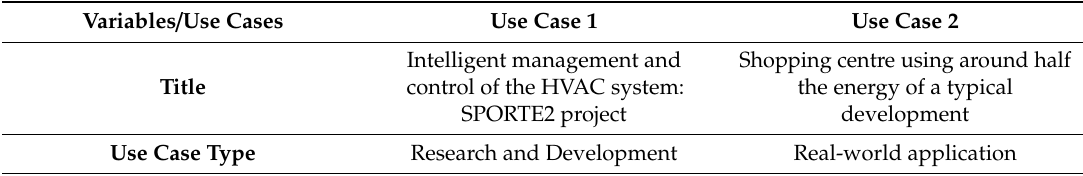
Table 1. Examples of BIM for energy e ffi ciency (EE) best practices